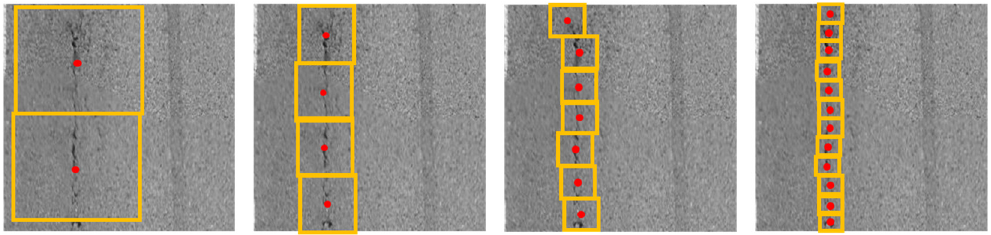
Figure 1. Illustration of the seed-growing strategy described in [10] for di ff erent seed-growing radius.